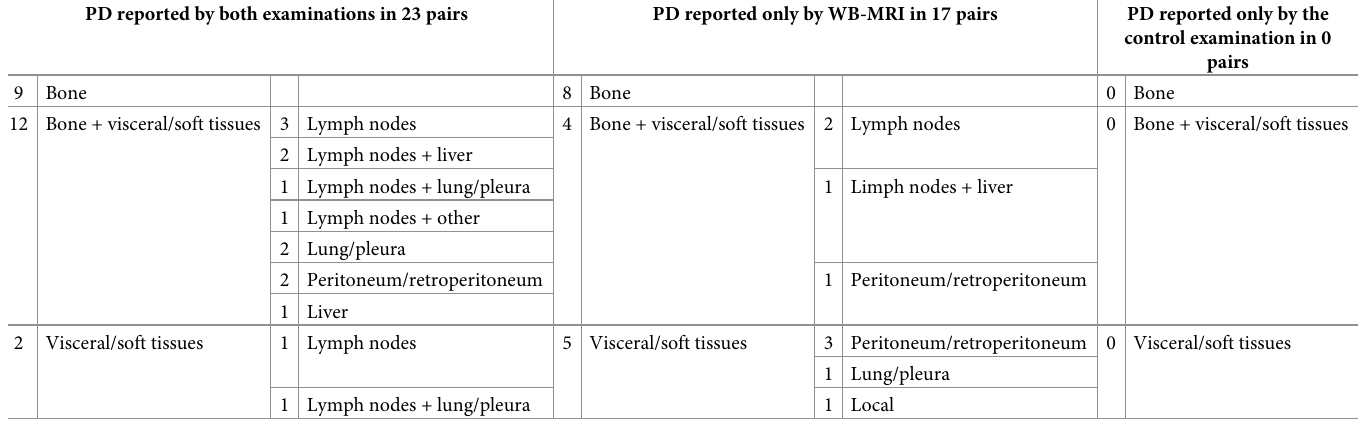
control examination in 0 pairs